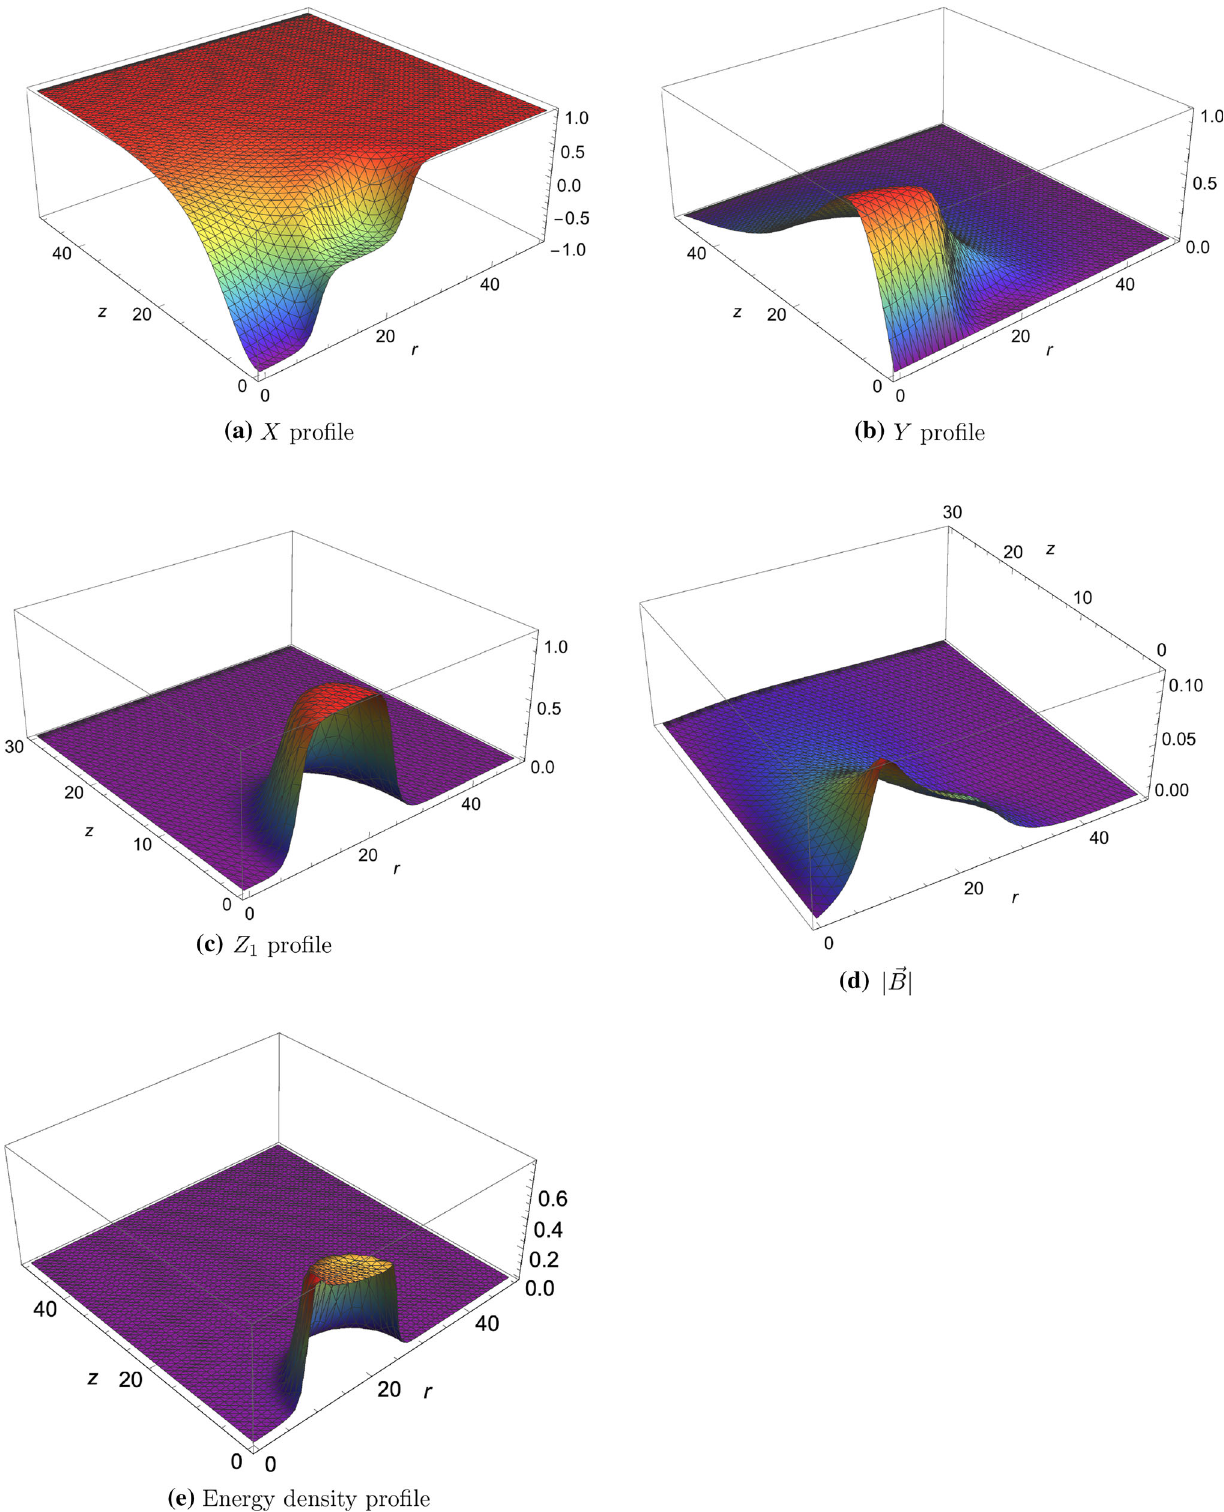
Fig. 3 Vorton profiles for X , Y , and Z 1 components. The magnetic field | (cid:8) B | = B φ = ∂ r A z and energy density for the solution are also shown. The parameters are n = 1, m = 6, λ φ = 4 . 5, λ σ = 4 . 0, γ = 2 . 8, Q = 20000, g = 0 . 1. For this value of Q , we find ω = 0 .